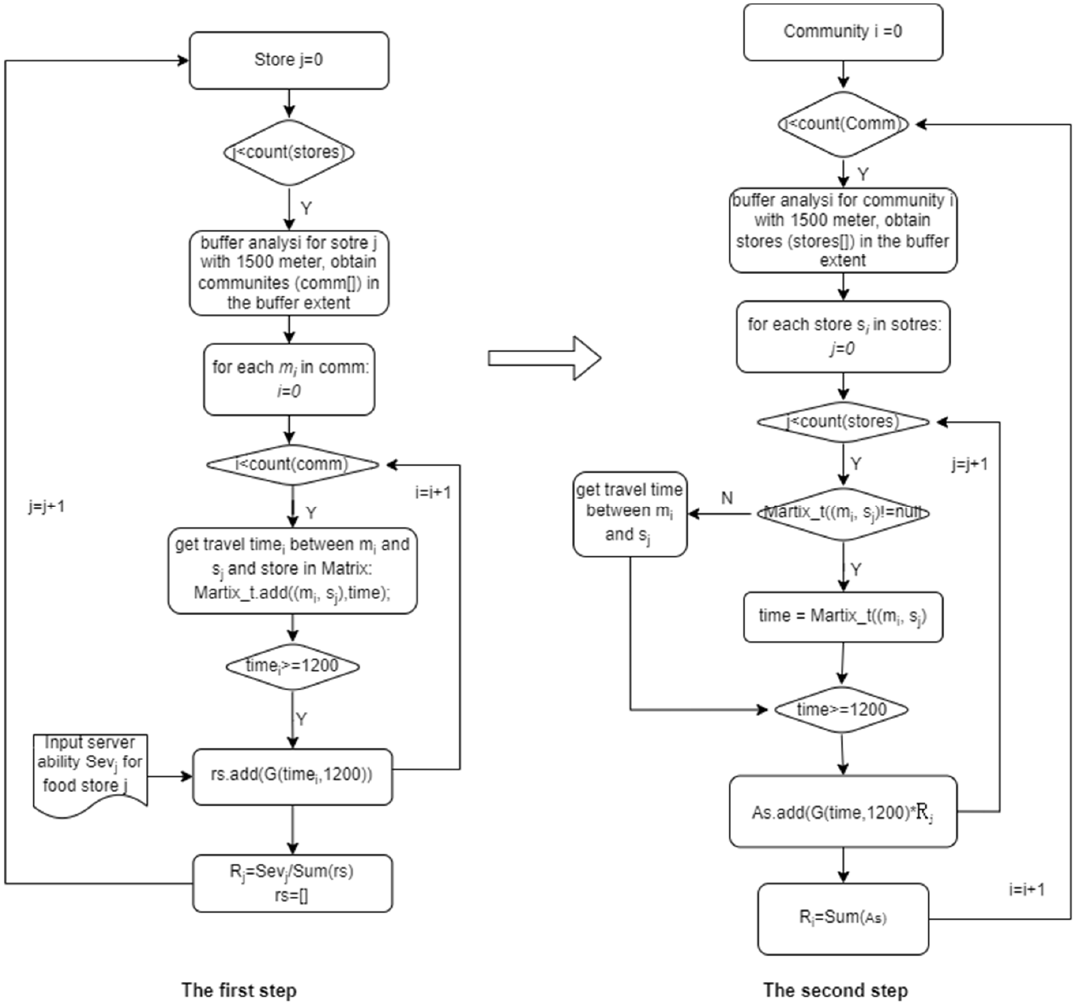
Figure 8. Enhanced two-step algorithm